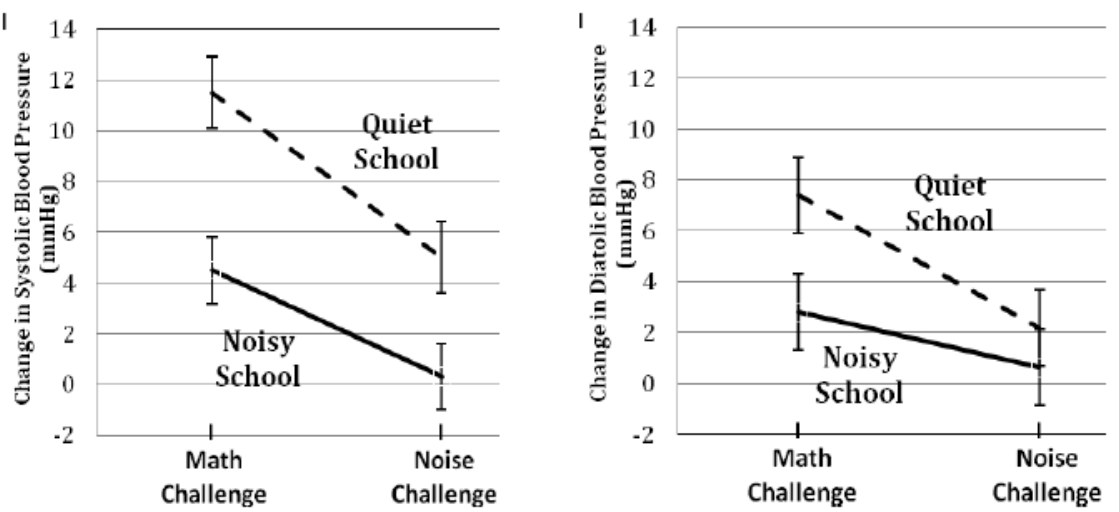
Figure 1. Systolic 1 and diastolic 2 blood pressure reactivity during acute math and noise stressors among children in the quiet versus noisy elementary school (n =